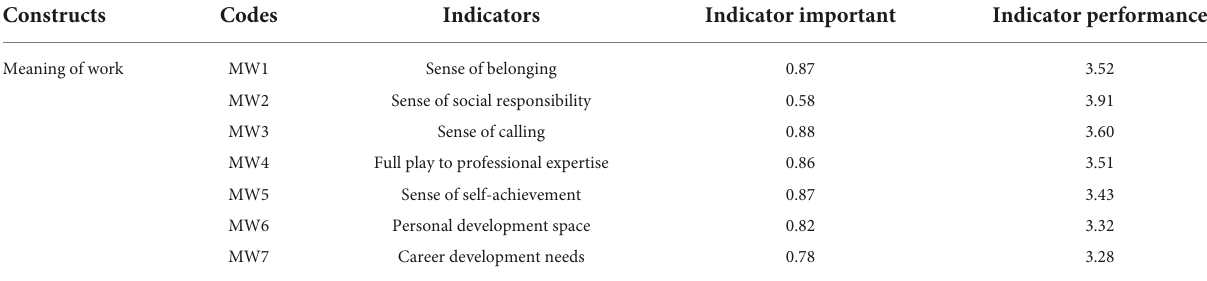
TABLE 5 Importance and performance data for study indicators and constructs. Constructs Codes Indicators Indicator important Indicator